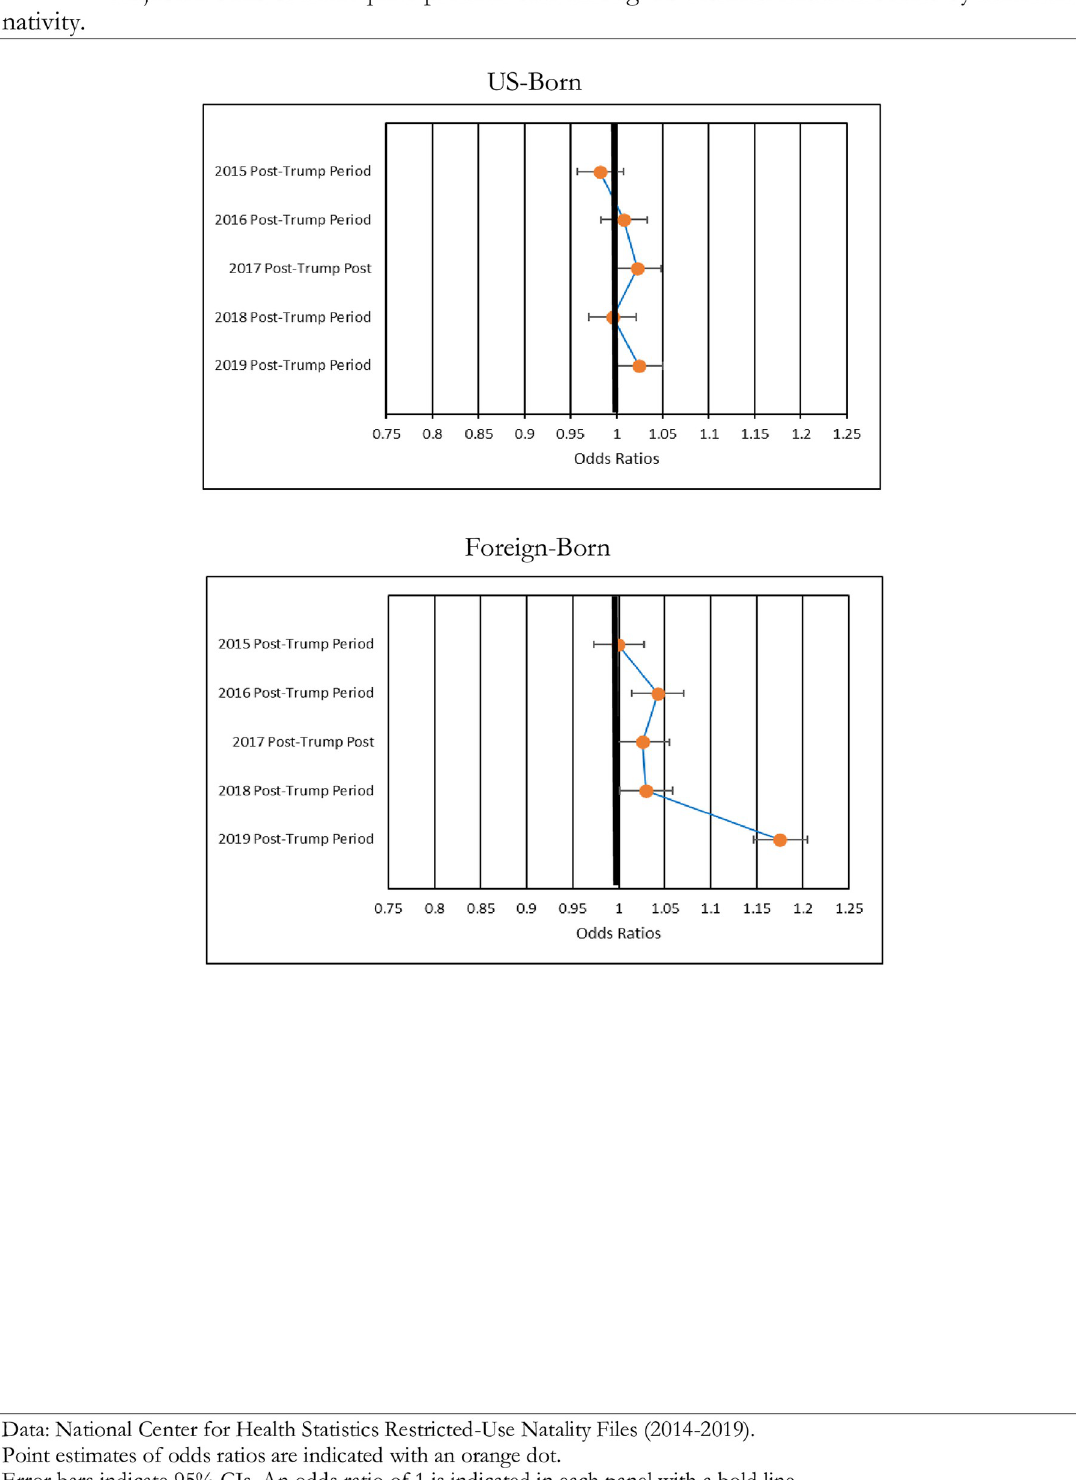
Fig 3. Adjusted odds of inadequate prenatal care relative to pre-trump period by maternal nativity.